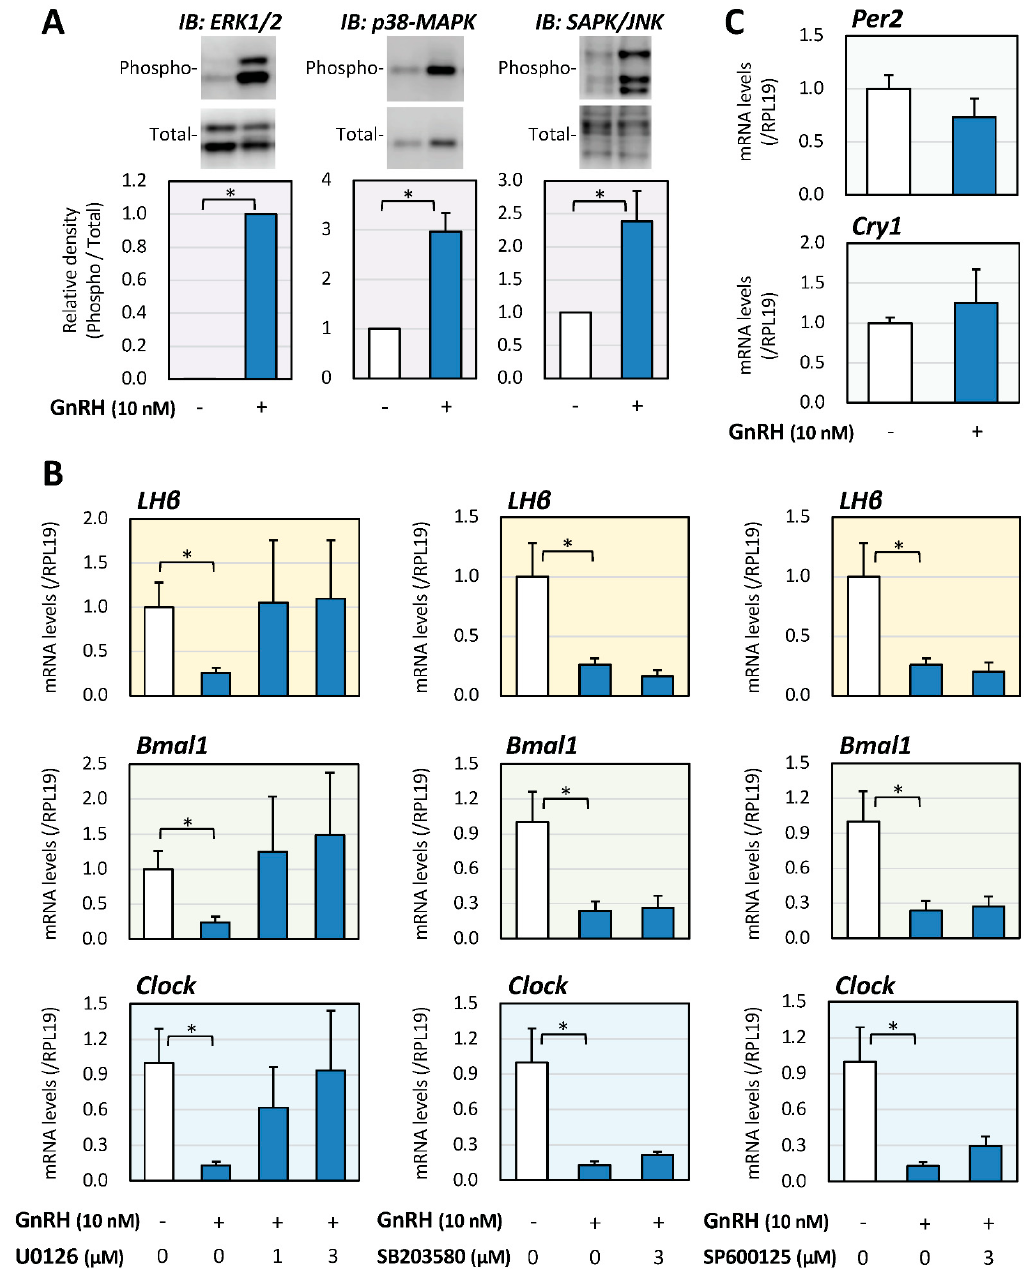
Figure 2. Involvement of MAPK in the regulation of LH and Clock gene expression induced by GnRH in gonadotrope cells. ( A ) L β T2 cells (1 × 10 5 cells/mL) were stimulated with GnRH (10 nM) in serum-free DMEM, and after 15-min stimulation, the cells were lysed and subjected to immunoblot (IB) analysis using antibodies that detect phosphorylation of MAPKs. The results are representative of those obtained from at least three independent experiments. The relative integrated density of the ERK protein band was digitized, with the phosphorylated levels being normalized by the total levels, and the results were expressed as fold changes. Results are shown as means ± SEM and were analyzed by the unpaired t -test: * p < 0.05 between the indicated groups. ( B ) Cells (1 × 10 5 cells/mL) were treated with the indicated concentrations of GnRH and MAPK inhibitors, including U0126, SP203580, and SP600125 in serum-free conditions for 6 h. Total RNAs were extracted, and the mRNA levels of LH β , Bmal1, and Clock were standardized by RPL19 levels and expressed as fold changes. Results are shown as means ± SEM and were analyzed by the ANOVA: * p < 0.05 between the indicated groups. ( C ) Cells (1 × 10 5 cells/mL) were treated with GnRH (10 nM) in serum-free conditions for 6 h, and after the extraction of total RNAs, the mRNA levels of Per2 and Cry1 mRNA were standardized by RPL19 levels and expressed as fold changes. Results are shown as means ± SEM and were analyzed by the unpaired t